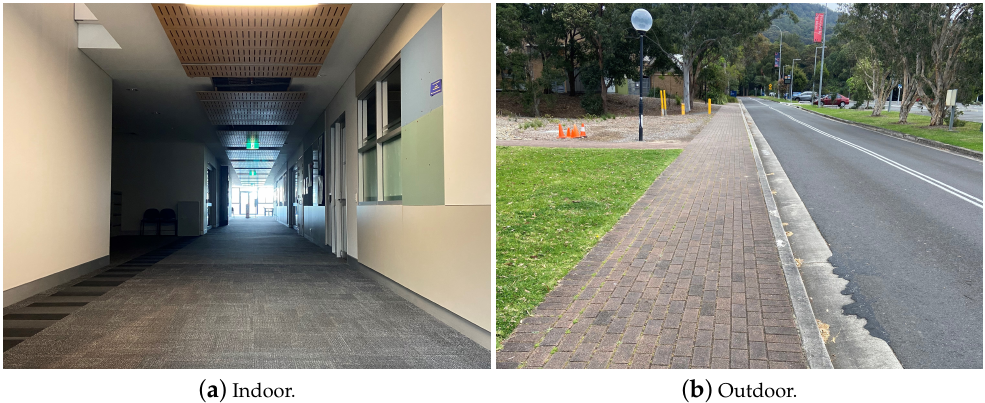
Figure 3. Experimental